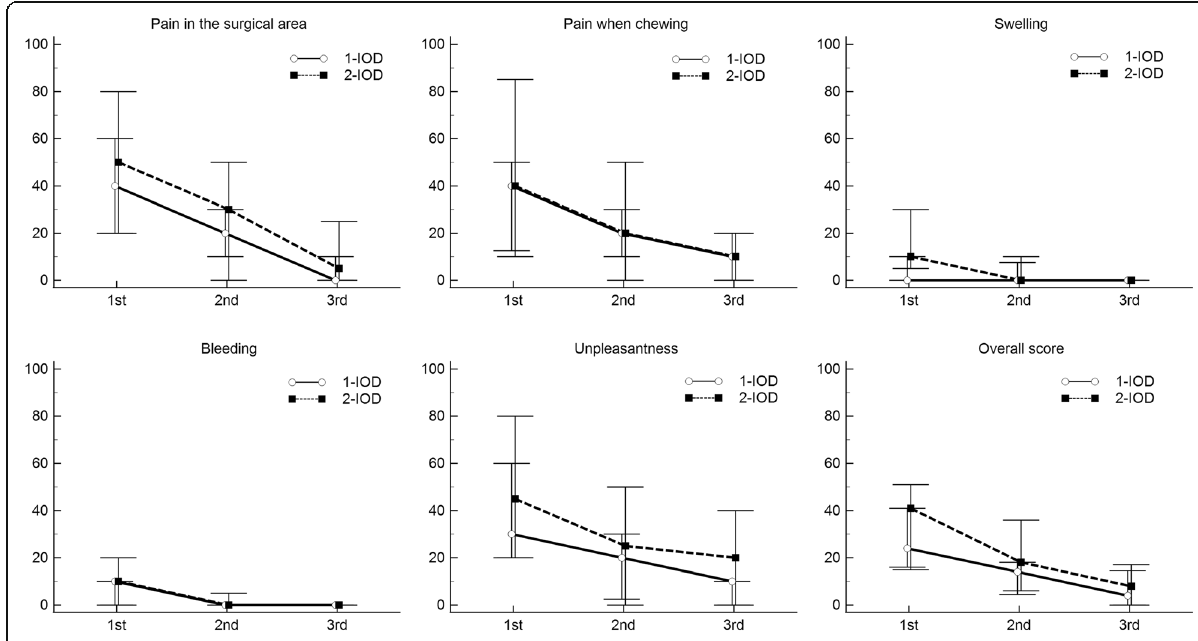
Fig. 2 Changes in postsurgical outcomes according to the follow-up period and treatment